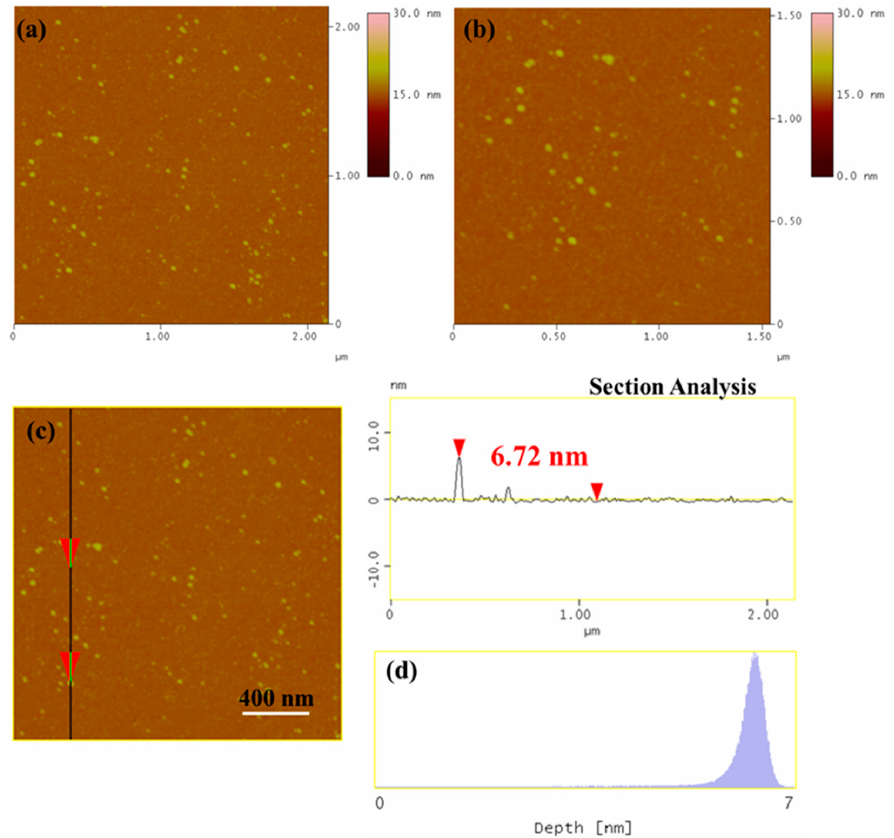
Figure 8. ( a , b ) AFM height images, ( c ) cross sectional analysis line, and ( d ) particle size distribution of AgNPs deposited on a Si-wafer.